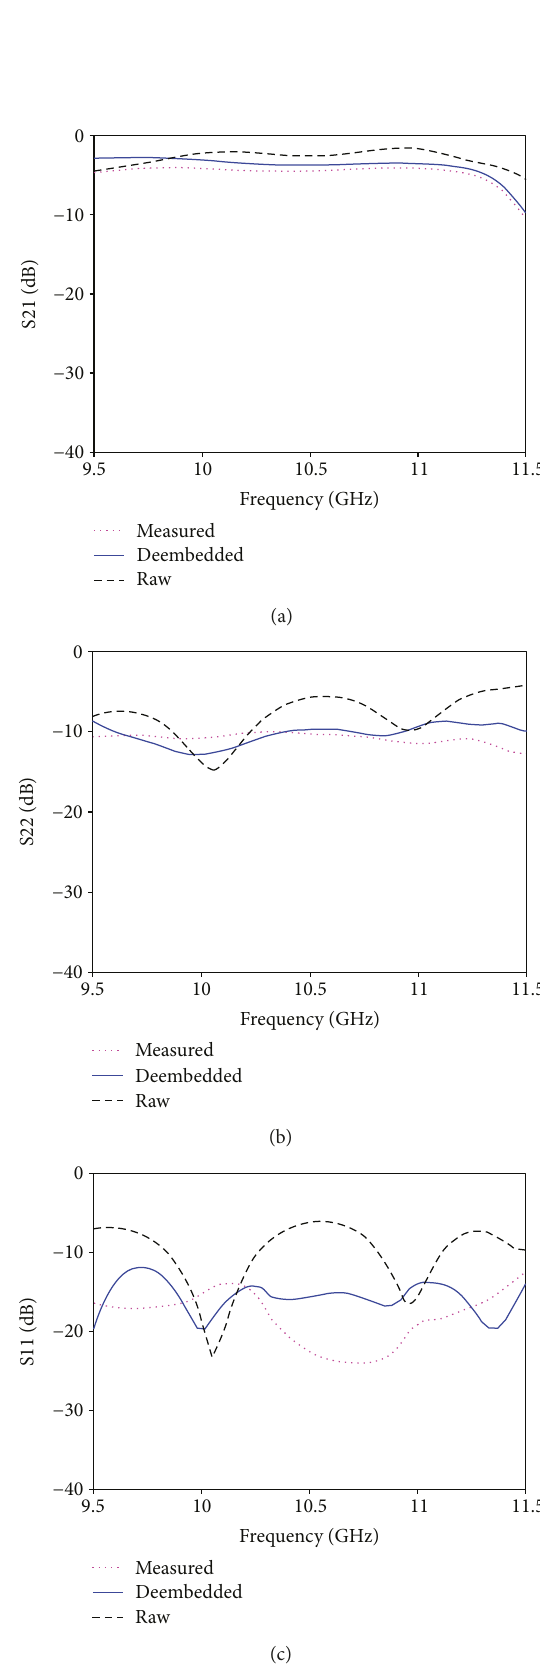
Figure 13: Characteristic S-parameters before and after deembedding of EBG guide with 3 rows and 8 periods. Raw is the simulated result of DUT. (a) S21, (b) S22, and (c)